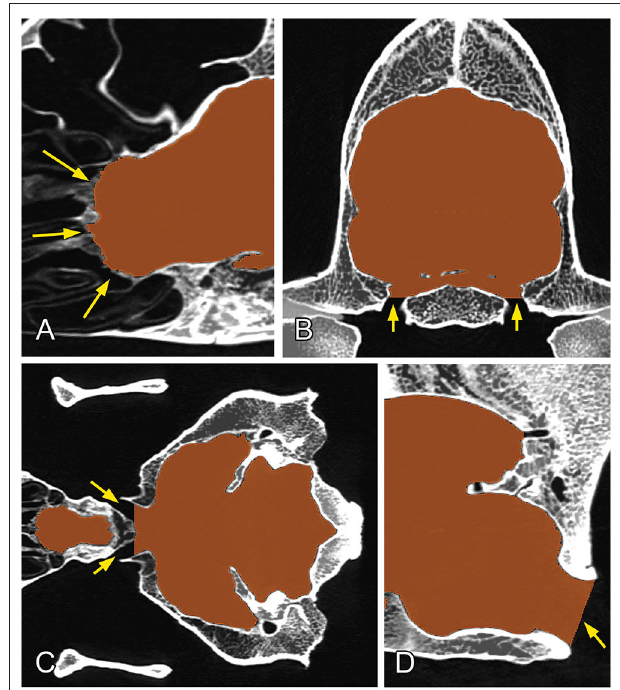
FIGURE 4 | Closure of the different channels and openings of the neurocranium. (A) At the region of the lamina cribrosa (sagittal plane). (B) At the level of the foramen ovale (transverse plane). (C) At the level of the chiasma opticum (dorsal plane). (D) At the region of the foramen magnum (midsagittal plane). Yellow arrows show the